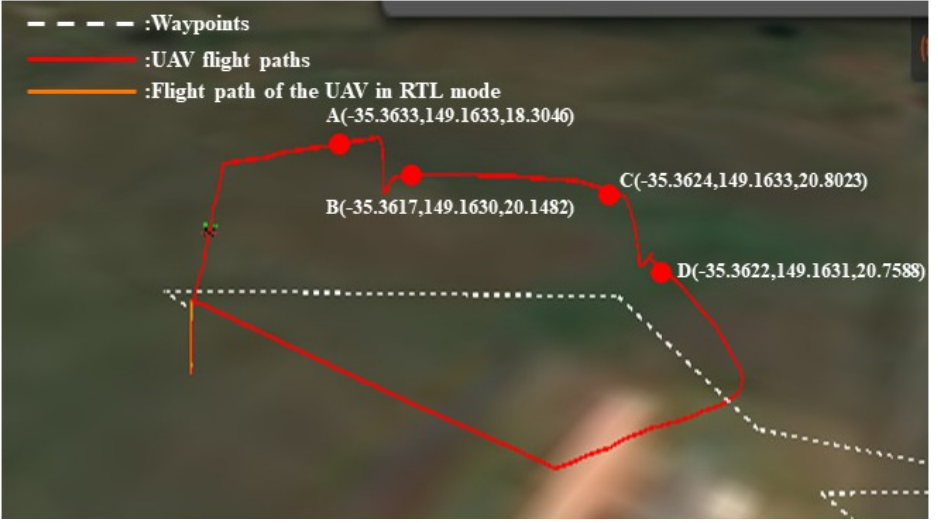
Figure 13. The fl ight trajectory of the UAV in the state of engine power loss. Figure 13. The flight trajectory of the UAV in the state of engine power